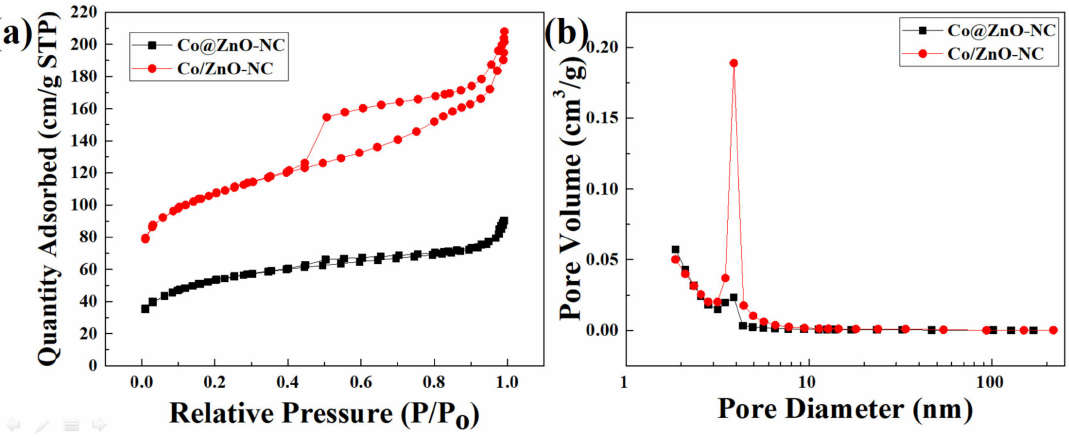
Figure 5. ( a ) N 2 adsorption isotherms and ( b ) pore size distributions of Co@ZnO-NC and